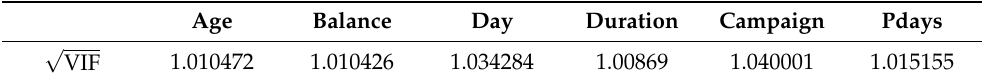
Table 4. Variance inflation factor.